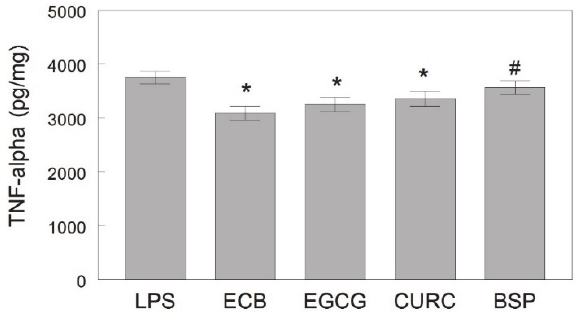
Figure 4. Suppression of TNF- α release in HAPI rat microglial cells pre-treated with ECB or its component phytochemicals (EGCG, CURC, BSP) and stimulated 18 h overnight with LPS (100 ng/mL). Data are expressed as mean ± SEM (pg/mg) as assayed by ELISA. Each pre-treatment was compared against LPS alone and individual components were compared to ECB. Comparative post-hoc analyses were made by Fisher’s LSD post-hoc test with significance at (*) p < 0.05 versus LPS or (#) p < 0.05 versus ECB. LPS = lipopolysaccharide only; ECB = combination compound; EGCG = epigallocatechin gallate; CURC = curcumin; BSP = broccoli